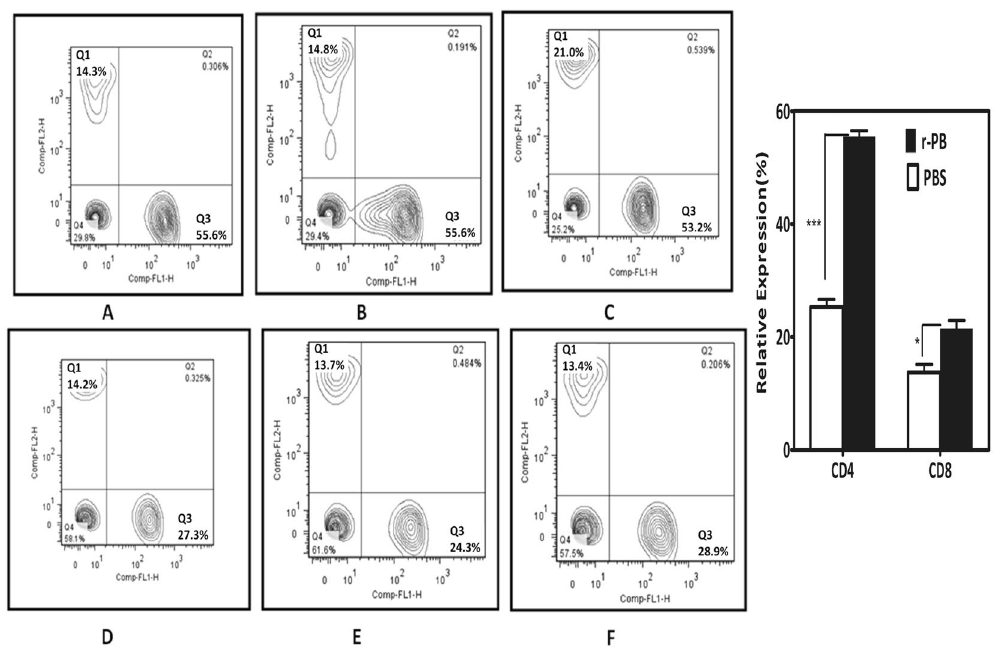
Figure 6. Relative expression of CD4 + and CD8 + T-cells estimated by flow cytometric analysis using FITC anti-mouse CD4 and PE anti-mouse CD8 monoclonal antibodies. Anti-coagulant treated peripheral blood samples from r-PB and sham immunized mice after 42 nd day of immunization were used in this assay. ( A ). Representative graphs showing percentage of CD4 + and CD8 + T cells within gated CD3 + T cell population. CD8 + T cell % (Q1), CD4 + and CD8 + T cell % (Q2), CD4 + T cell % (Q3), CD4 − ve /CD8 − ve T cell % (Q4). ( B